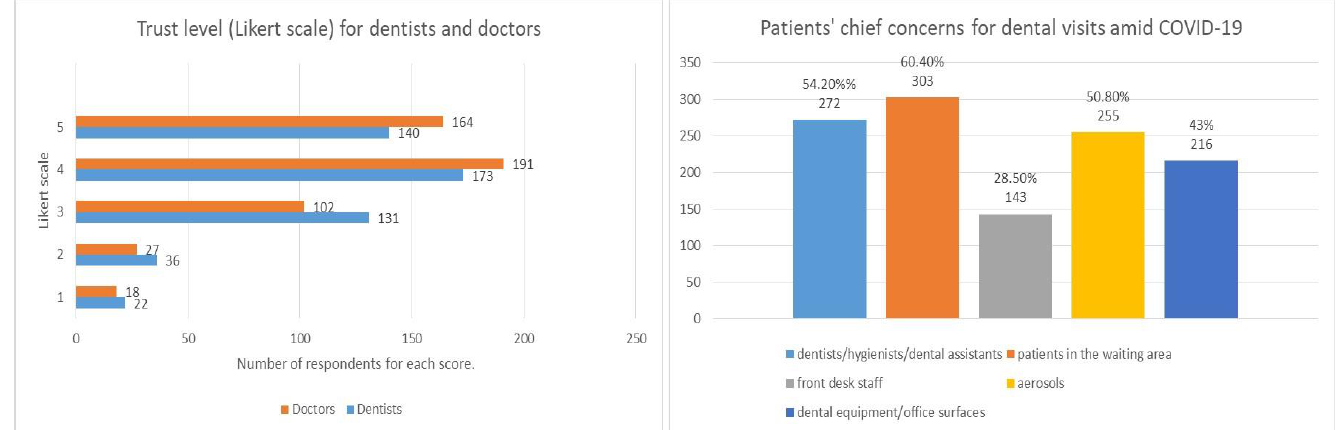
Figure 2 Trust ratings based on a 5-point Likert scale for dental offices/dentists and medical offices/doctors. 1 is the lowest and 5 is the highest trust rating.